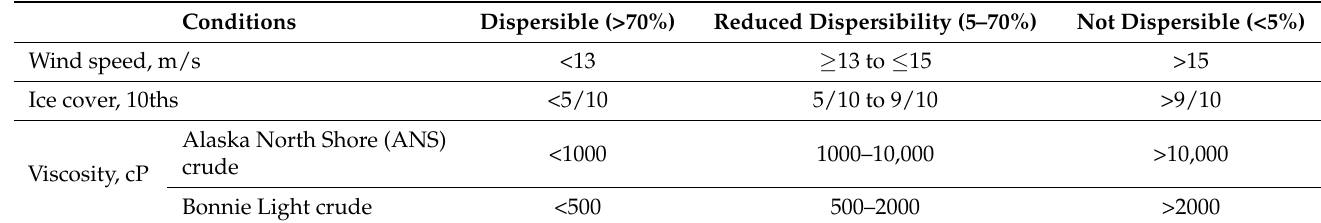
Table 4. Operating limits of dispersants [19,20].